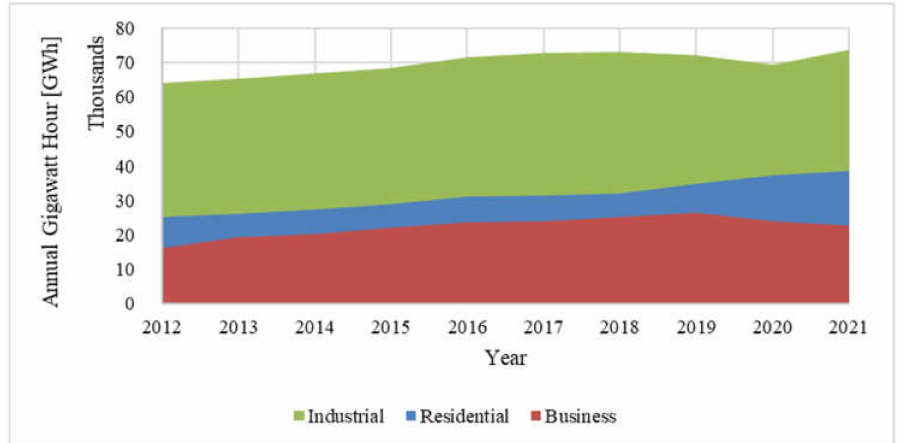
Figure A1. Historic electricity consumption in Provincial Electricity Authority Area based on data by [2].